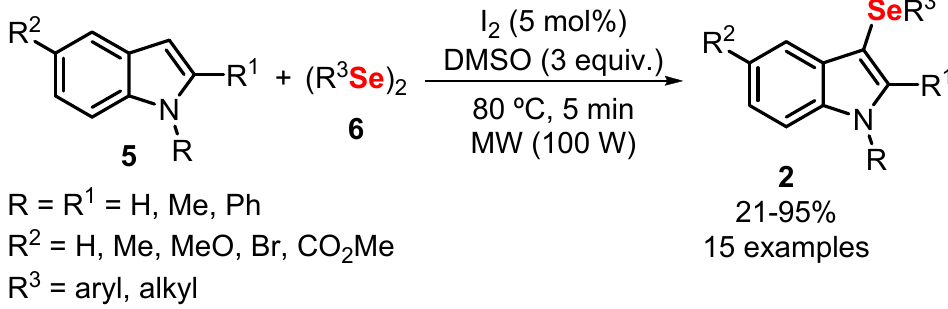
Scheme 2. Microwave ‐ assisted synthesis of 3 ‐ selenylindoles 2 .